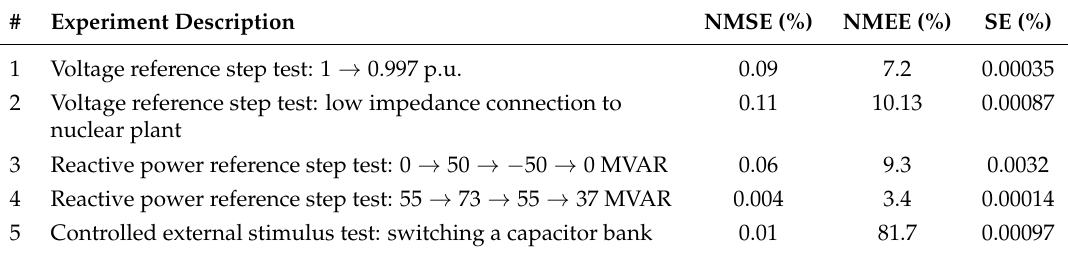
Table 2. Volt/VAR control verification experiments: comparison of simulation and experimental